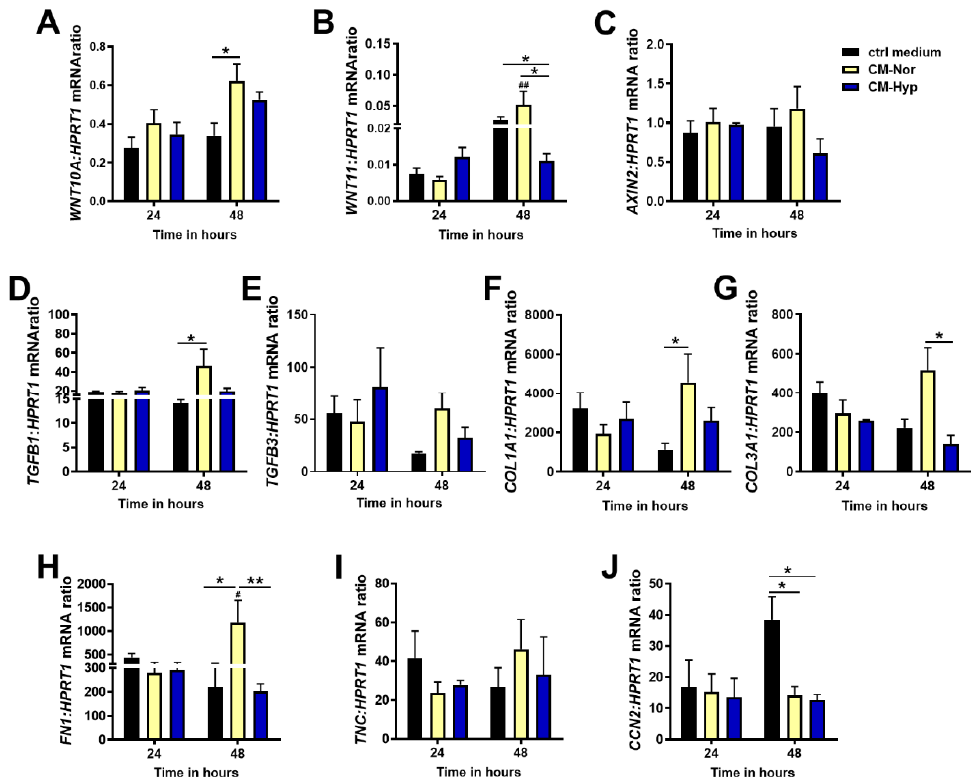
Figure 6. Quantitative analysis of: ( A ) WNT10A , ( B ) WNT11 , ( C ) AXIN2 , ( D ) TGFB1 , ( E ) TGFB3 , ( F ) COL1A1 , ( G ) COL3A1 , ( H ) FN1 , ( I ) TNC , and ( J ) CCN2 mRNA expression in pDFs exposed for 24 and 48 h to CM-Nor (yellow bars) or CM-Hyp (blue bars) relative to control-treated cells (black bars). The results are shown as the mean ± SD. The asterisks indicate significant differences between specific mRNA expression at 48 h (* p < 0.05; ** p < 0.01). Hashes show significant differences in mRNA between 24 and 48 h of culture ( # p < 0.05; ## p < 0.01). Abbreviations: pDFs, pig dermal fibroblasts; CM-Nor, conditioned medium collected from pASCs exposed to normoxia; CM-Hyp, conditioned medium collected from pASCs cultured under hypoxia.